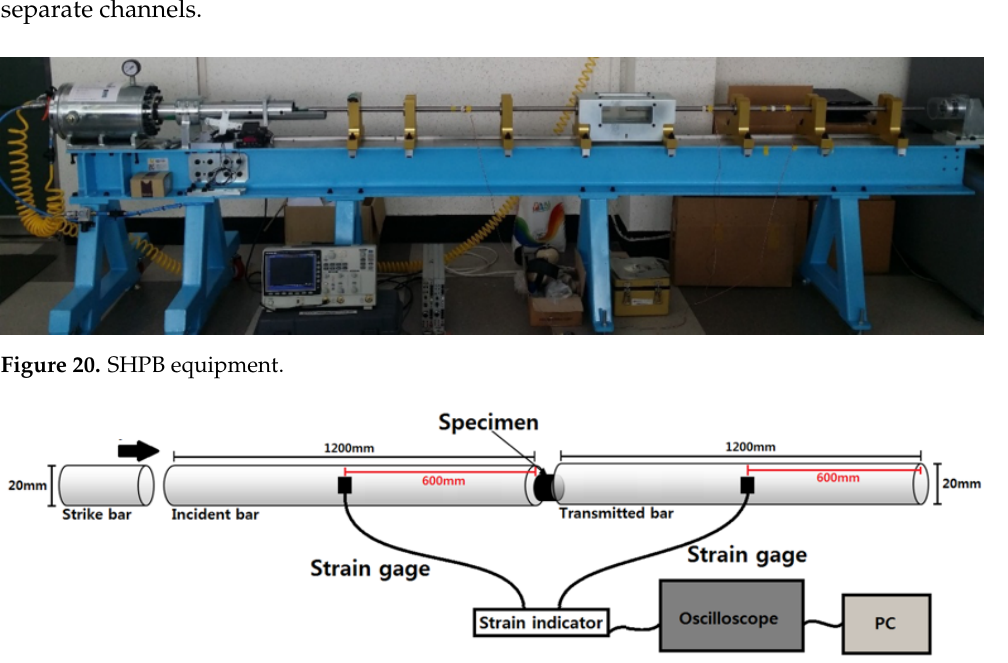
Figure 21. Schematic of the SHPB equipment with a DAQ